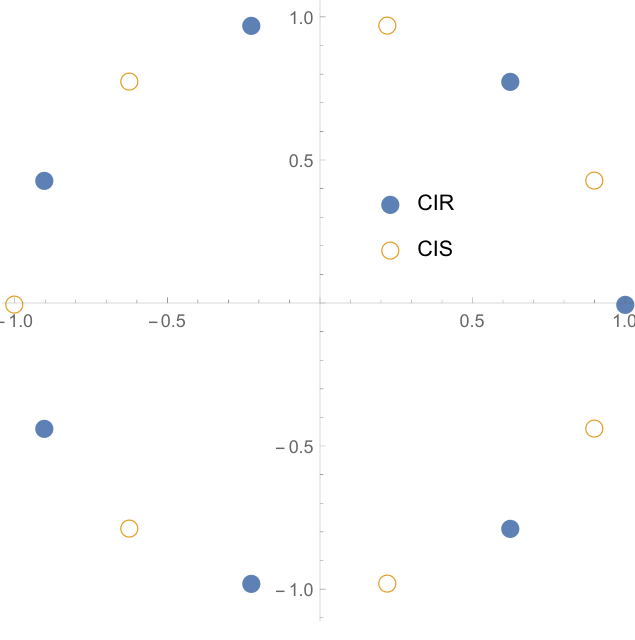
Figure 3. Nodes of the CIR and CIS NIZT methods for N = 7 in the complex plane